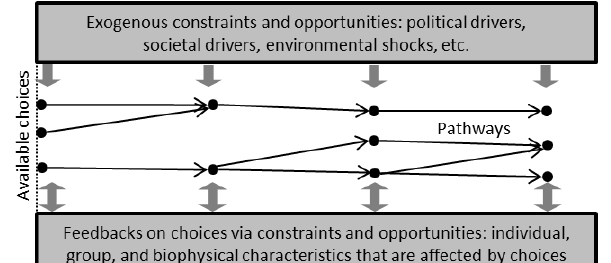
Fig. 1. Pathways and pathway diversity. The diversity of future pathways is constrained and enabled by exogenous and endogenous drivers and endogenous feedbacks. Fig. 2. State-of-the-art resilience theoretical frameworks. (A)